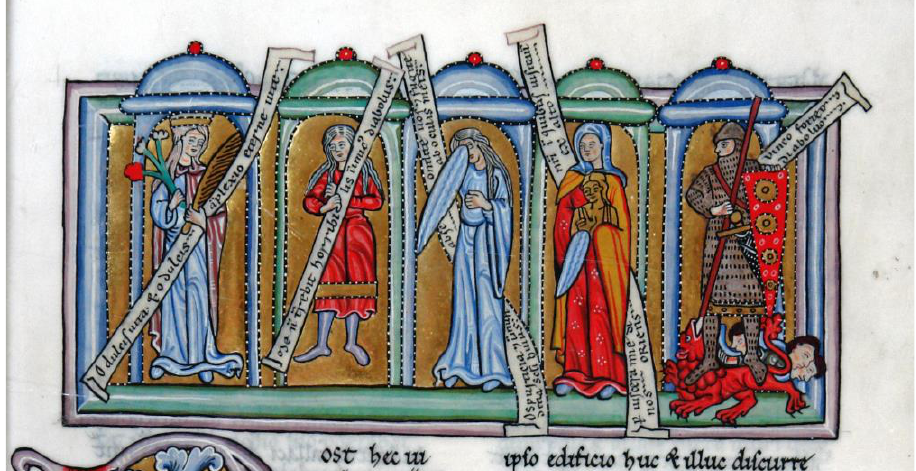
Figure 5. Scivias 3.5: The Tower of the Anticipation of God’s Will. Rüdesheim/Eibingen, Benediktin- erinnenabtei St. Hildegard, MS 1, fol. 139r. By permission of the nuns of the Benediktinerinnenabtei St.